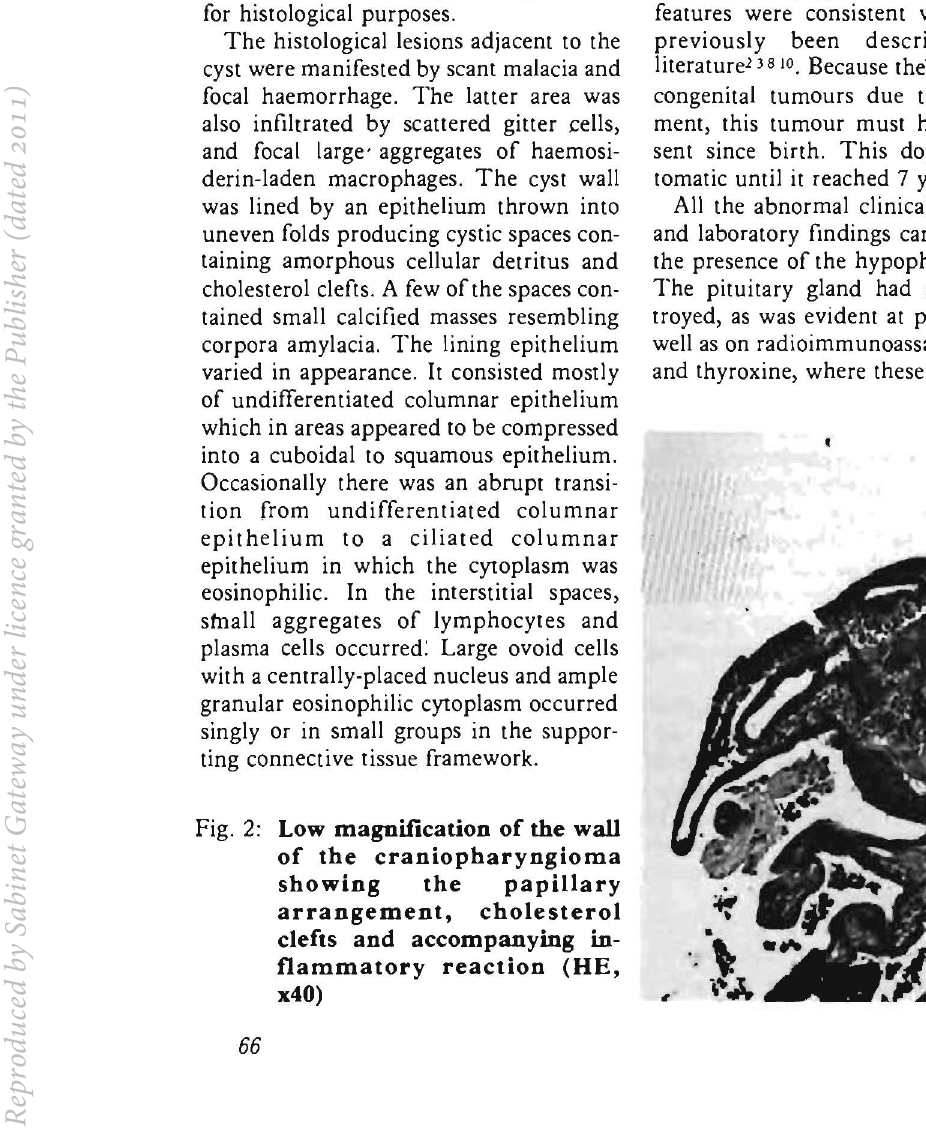
Fig. 2: Low magnification of the wall of the craniopharyngioma showing the papillary arrangement, cholesterol clefts and accompanying